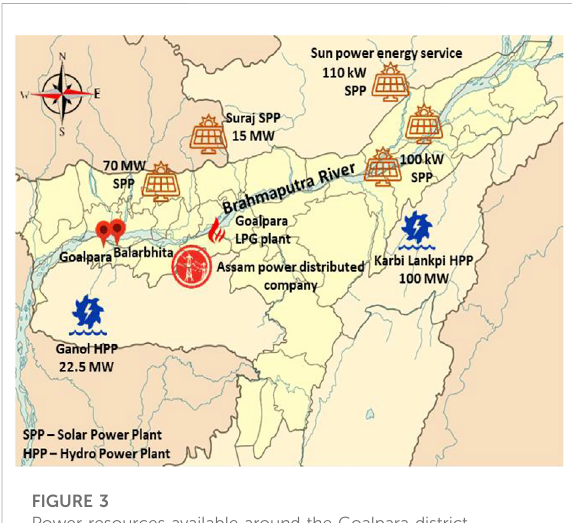
FIGURE 3 Power resources available around the Goalpara